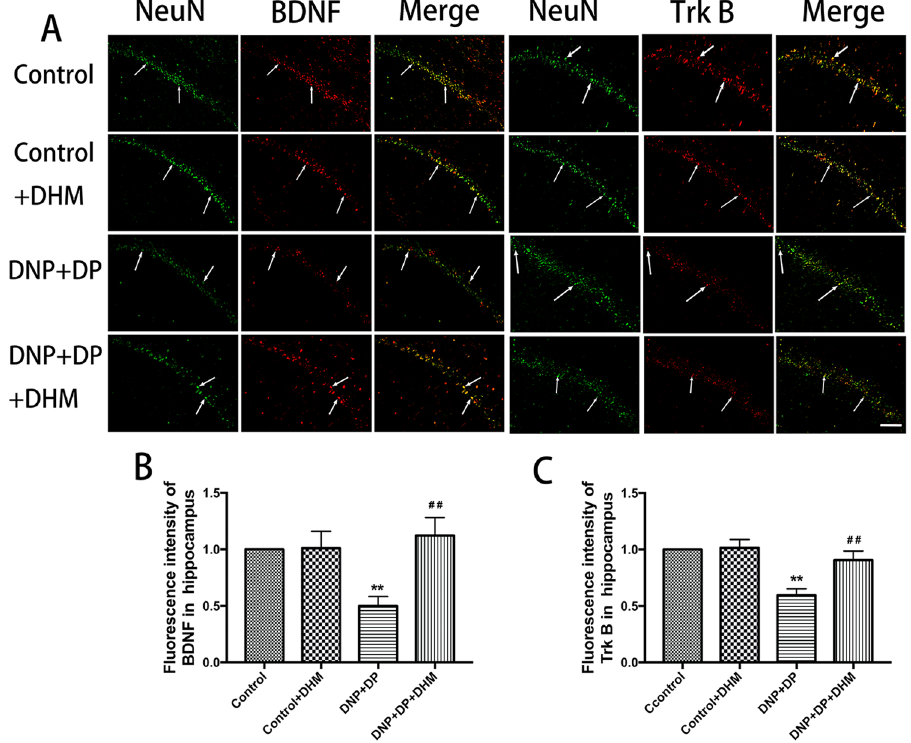
Figure 7. Co-expression of NeuN-BDNF ( A , B ) and NeuN-TrkB ( A , C ) in the hippocampus was detected with double-labelled immunofluorescence. Values are the mean ± SEM of 3 observations. ** p < 0.01 vs . control